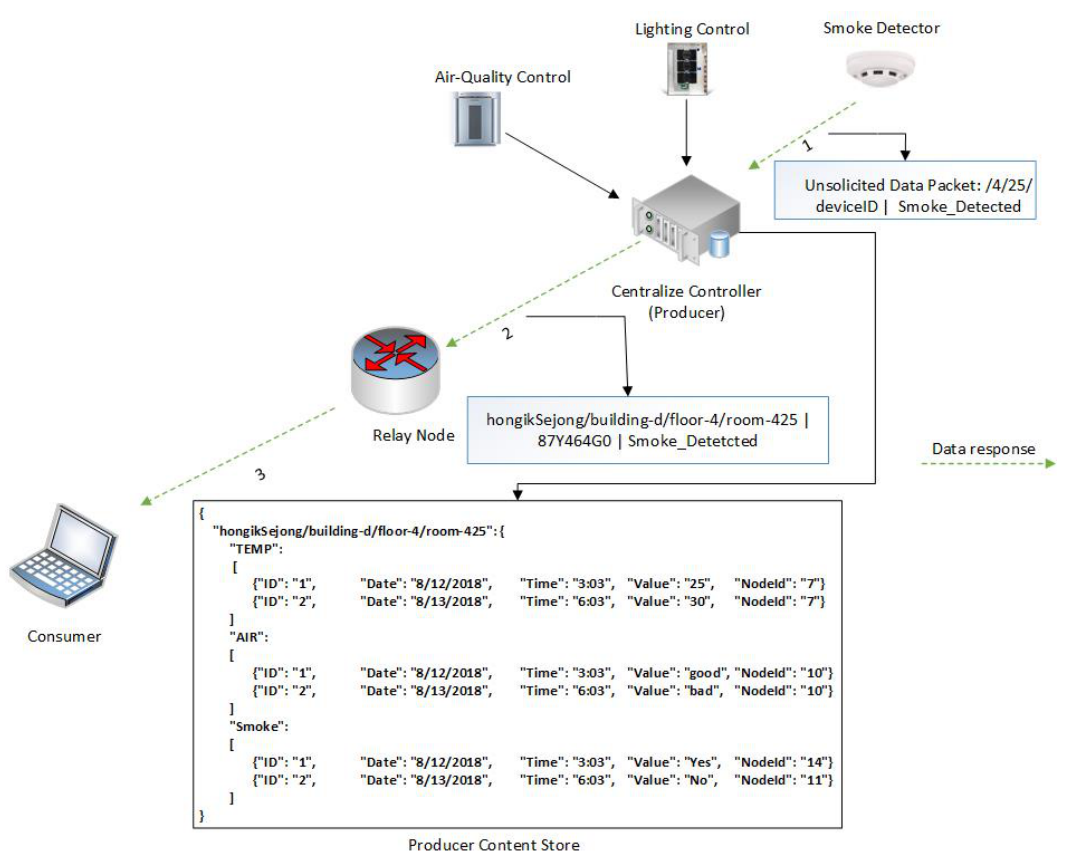
Figure 7. Push service